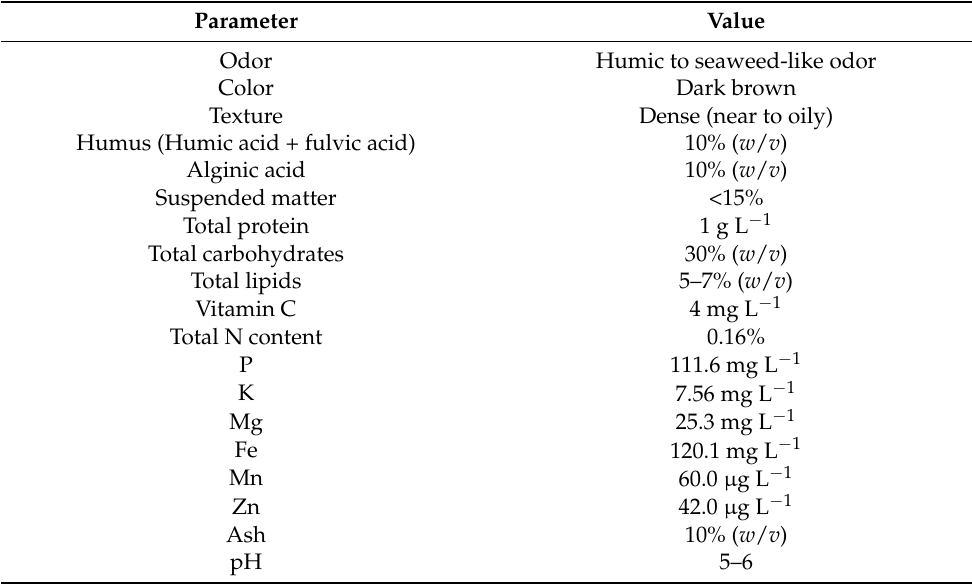
Table 2. Chemical composition of seaweed extract and humic substances formulation.